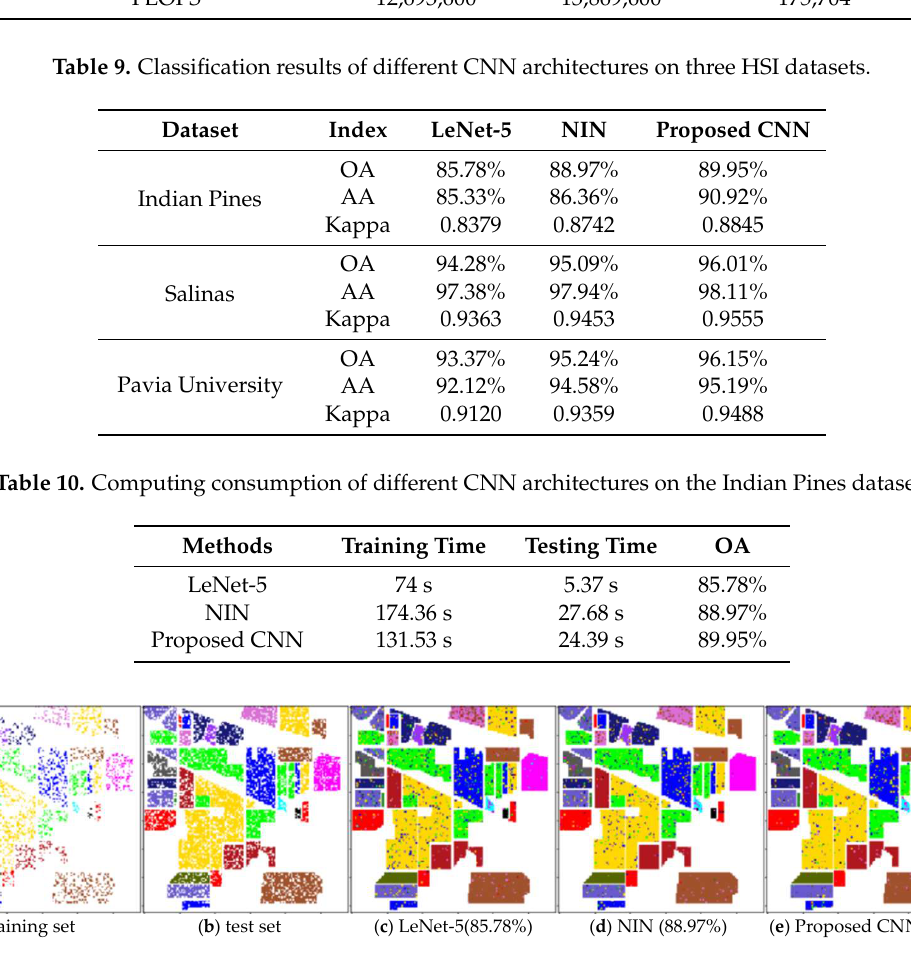
Figure 15. Classification maps of different CNN architectures on the Indian Pines dataset.